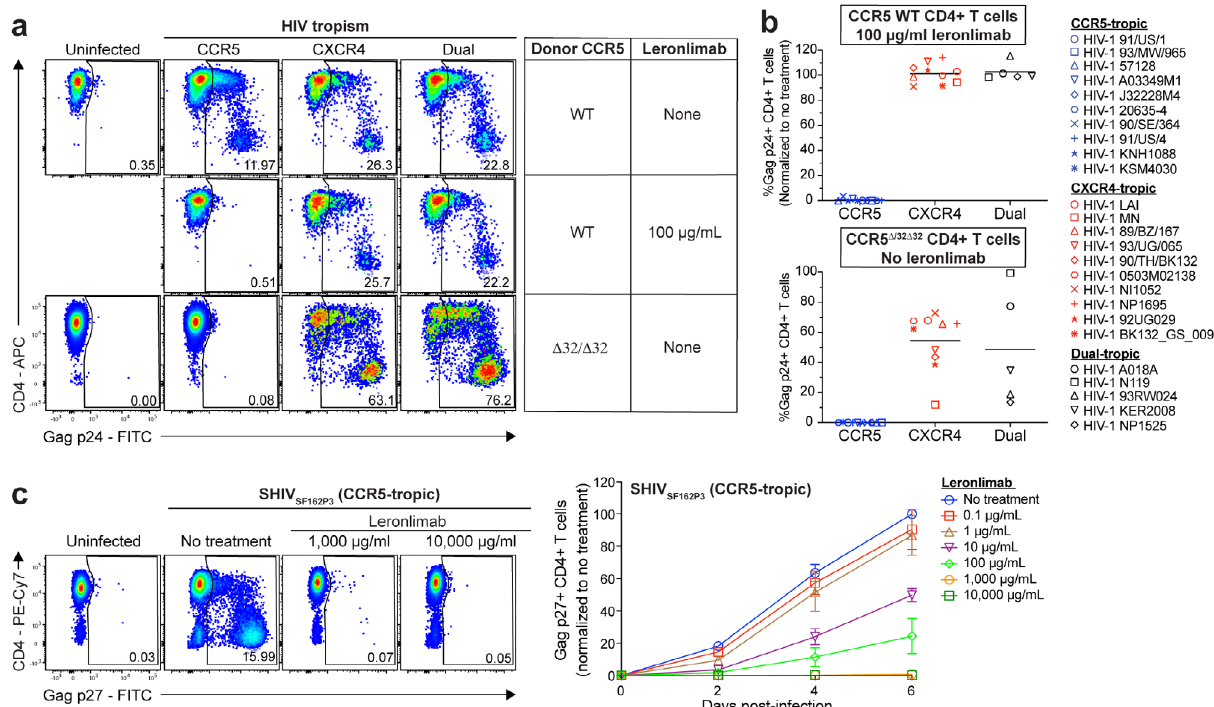
Fig. 1 Leronlimab blocks the spreading of CCR5-utilizing strains in vitro. a Representative fl ow cytometry plots displaying intracellular Gag p24 staining of untreated CCR5 wild type (WT), Leronlimab-treated CCR5 WT, and untreated CCR5 Δ 32/ Δ 32 human CD4 + T cells in HIV-1 infection assay with CCR5- tropic (blue), CXCR4-tropic (red), and dual-tropic viruses (black). b Summary of the mean Gag p24 levels from HIV-1 spreading assays performed on CCR5 WT human CD4 + T cells treated with 100 μ g/mL Leronlimab (top) or untreated CCR5 Δ 32/ Δ 32 human CD4 + T cells (bottom). Each data point represents the mean Gag p24 levels of CCR5 WT human ( n = 3) or CCR5 Δ 32/ Δ 32 human ( n = 1; two replicates) CD4 + T cells. Each viral tropism group represents the mean Gag p24 levels of ten CCR5-tropic, ten CXCR5-tropic, and fi ve dual-tropic viral infections. Gag p24 levels of CCR5 WT human CD4 + T cells were normalized to “ no treatment ” . c Spreading assay using SHIV SF162P3 , a CCR5-utilizing virus. Macaque CD4 + T cells ( n = 3) were infected and treated with increasing amounts of Leronlimab. (Right) Summary (mean ± SEM) of the longitudinal infection as measured by Gag p27 levels, with all values normalized to day 6 “ no treatment ” . Source data are provided as a Source Data fi